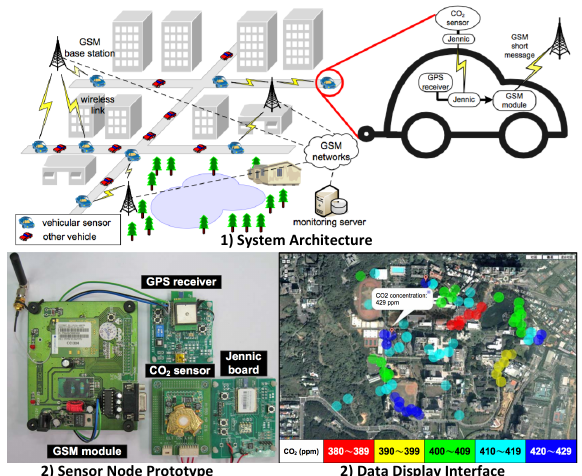
Figure 10. Example of the Vehicle Sensor Network (VSN) system architecture and prototype. Figures are adapted from